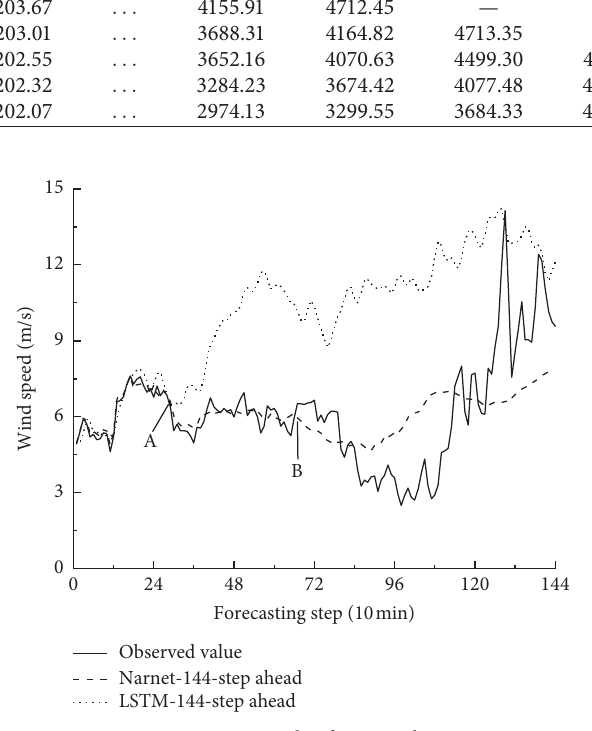
Figure 3: Mean result of ten predictions. Table 2: Evaluation of model prediction results.